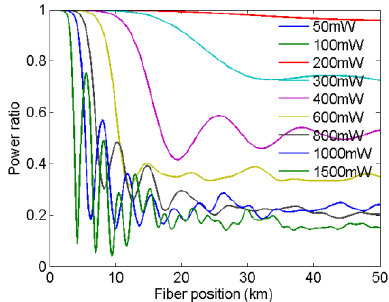
Figure 1. The relationship of R versus the transmission distance with different input powers.